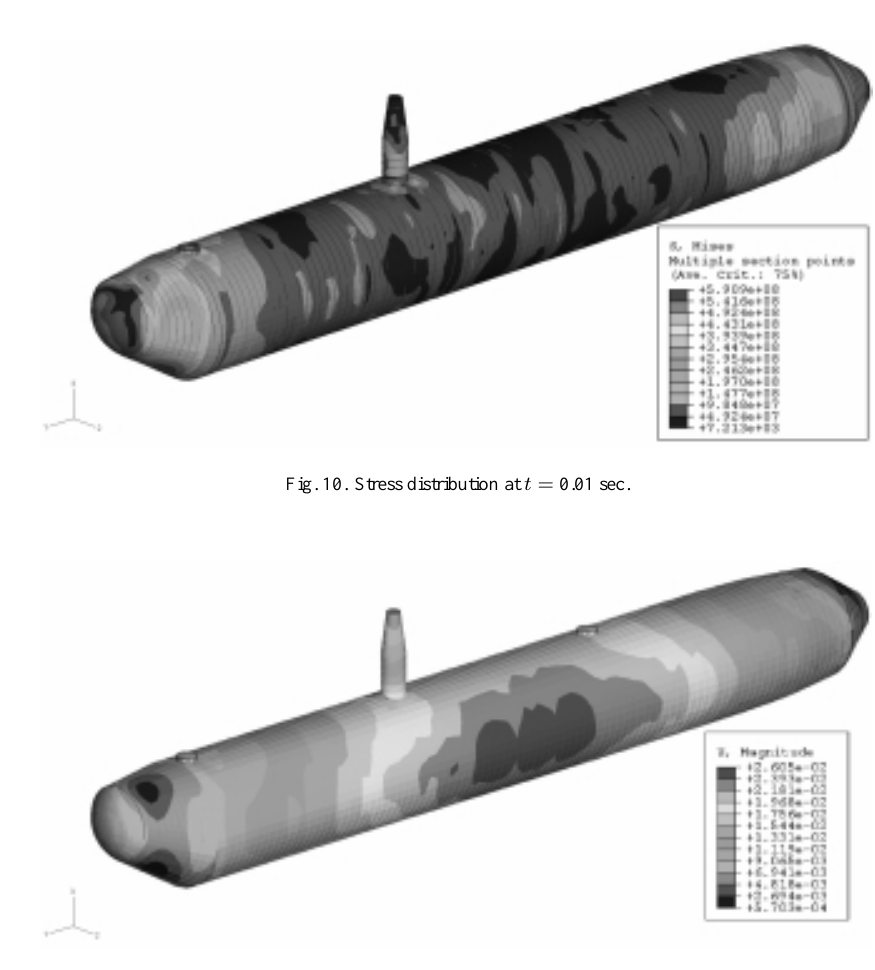
Fig. 11. Deformation distribution at t = 0.01 sec.